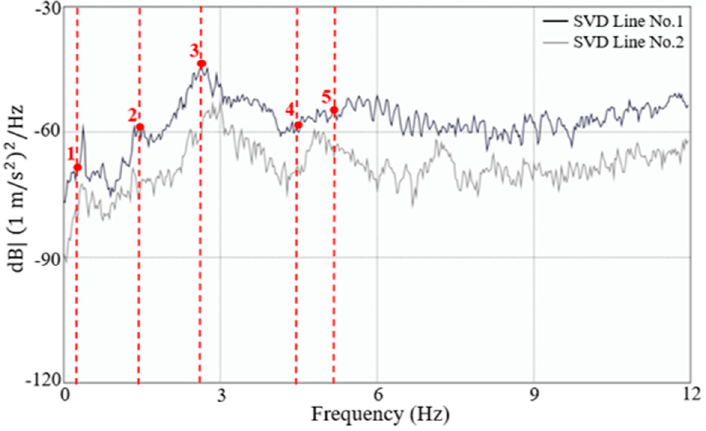
Figure 8. EFDD method: average normalised singular values of the spectral density matrices regarding AP comfort seat.